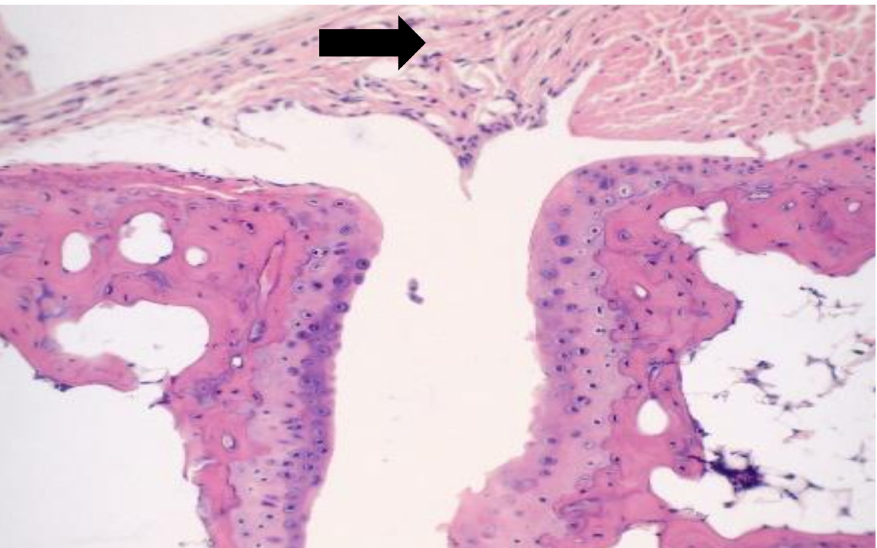
Figure 4. Non-infected mouse with normal joint. Photomicrograph of a normal joint with opposing normal articular cartilage with subchondral bone. There is no evidence of inflammation or erosion. A small amount of synovium (shown with arrow) is present, which appears normal. The joint capsule shows normal connective